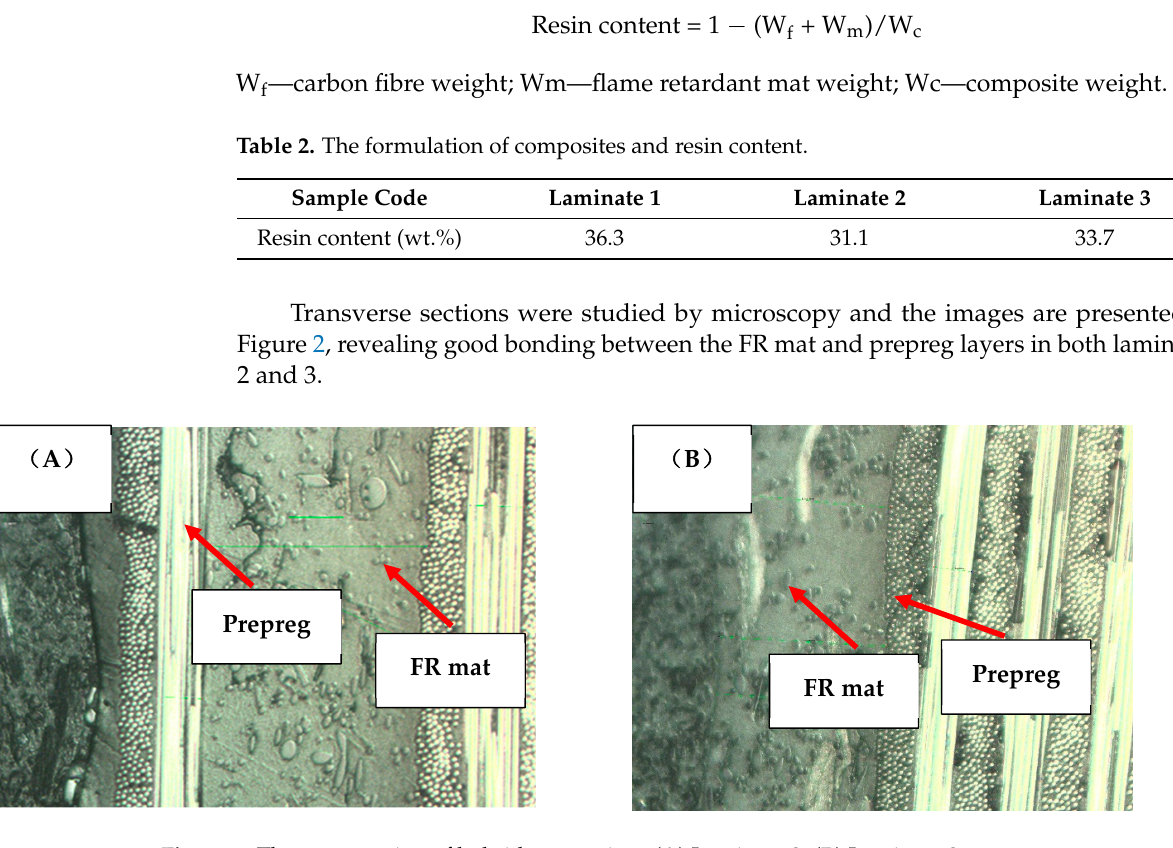
Figure 2. The cross-section of hybrid composites. ( A ) Laminate 2; ( B ) Laminate 3